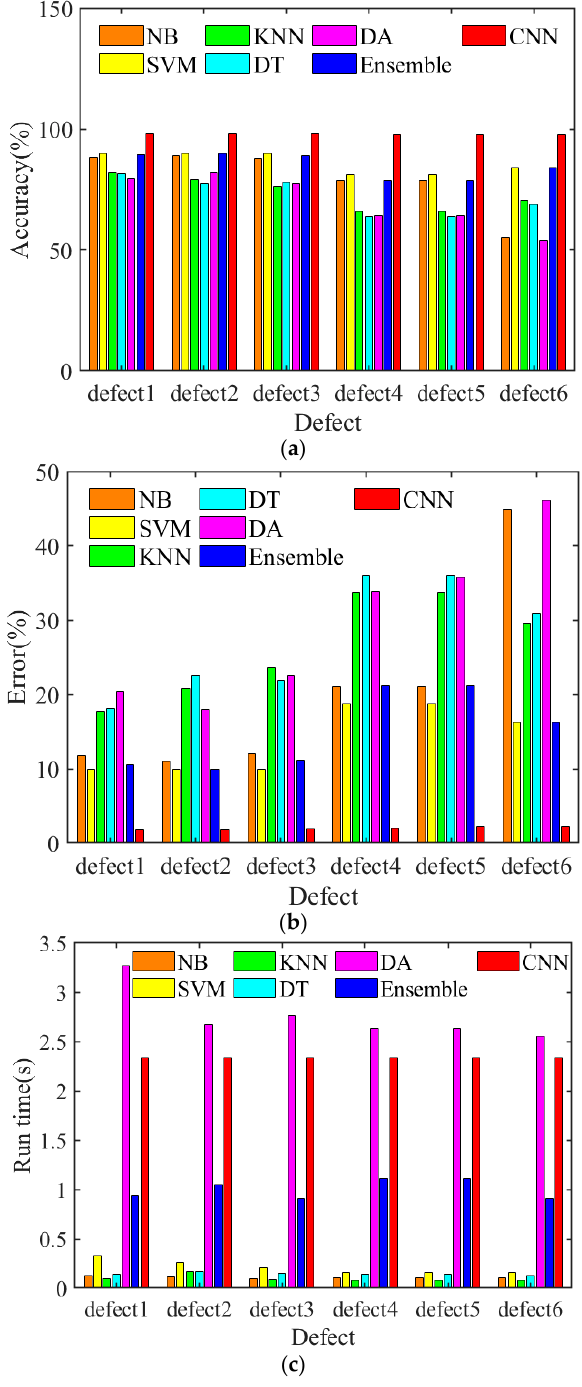
Figure 13. Histograms of the testing and comparisons results: ( a ) testing accuracy for wire rope defects by different classifiers; ( b ) testing error for wire rope defects by different classifiers; and ( c ) run time for wire rope defect recognition by different algorithms.